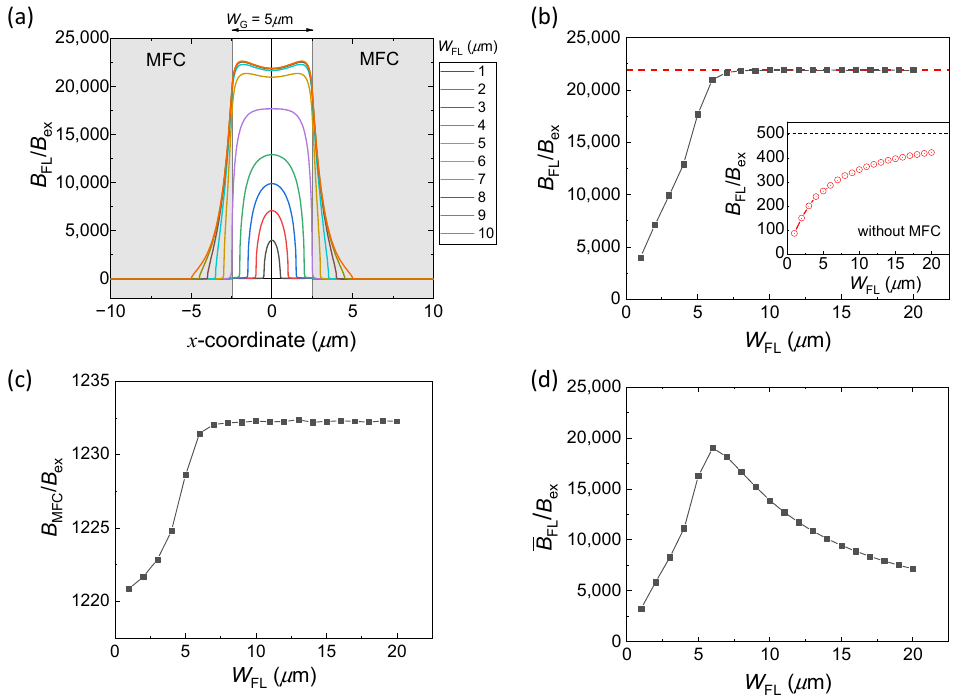
Figure 5. ( a ) B FL / B ex across the line passing through a center of the FL for different W FL ( W G = 5 µ m). ( b ) B FL / B ex at the center of the FL for different W FL . Inset of ( b ) shows B FL / B ex vs. W FL without MFCs. ( c ) B MFC / B ex vs. W FL curve, showing maximum B MFC / B ex for the cases with an MFC–FL overlap. ( d ) B ̅ FL / B ex at the center of the FL for W FL . B ̅ FL is the average magnetic flux density inside the FL defined by Equation (1).